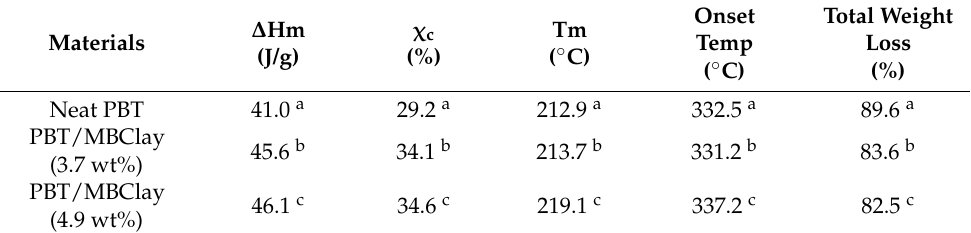
Table 3. Melting enthalpy, ∆ H m , melting temperature, T m crystallinity, χ c (%), onset degradation temperature, and total weight loss for the neat PBT and PBT/MBClay nanocomposites. ∆ Hm Materials